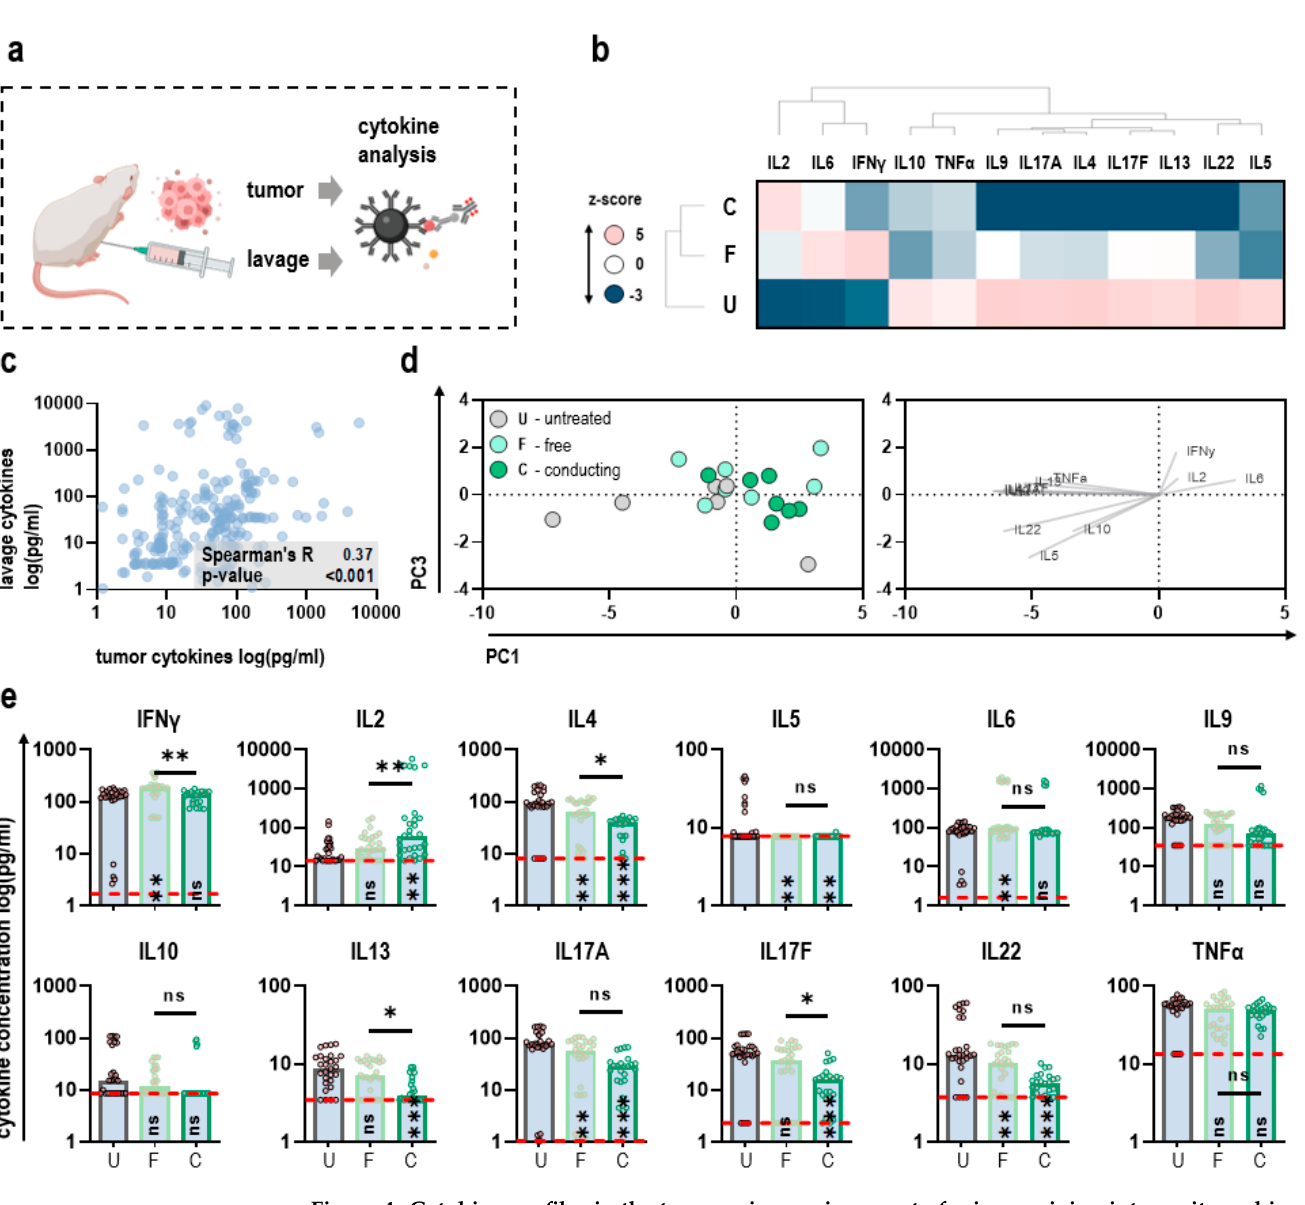
Figure 4. Cytokine profiles in the tumor microenvironment of mice receiving intraperitoneal injections of free or conducting oxRilac. ( a ) Schematic overview of samples obtained for cytokine analysis; ( b ) WPGMA-weighted hierarchical clustering calculated from z-scored intratumoral cytokine concentrations; ( c ) Spearman’s correlation between intra- and extratumoral (lavage) cytokine concentrations; ( d ) principal component analysis (PCA) calculated from z-scored intratumoral cytokine concentrations of individual animals showing PC scores and loadings; ( e ) absolute intratumoral cytokine concentrations. Bar graphs show medians and individual values. The limit of detection is indicated as a dashed red line. Statistical analysis was conducted using one-way analysis of variance (ANOVA) and Tukey’s post hoc testing (* p < 0.05, ** p < 0.01, *** p < 0.001). ns = nonsignificant; U = untreated; F = free mode; C = conducting mode.